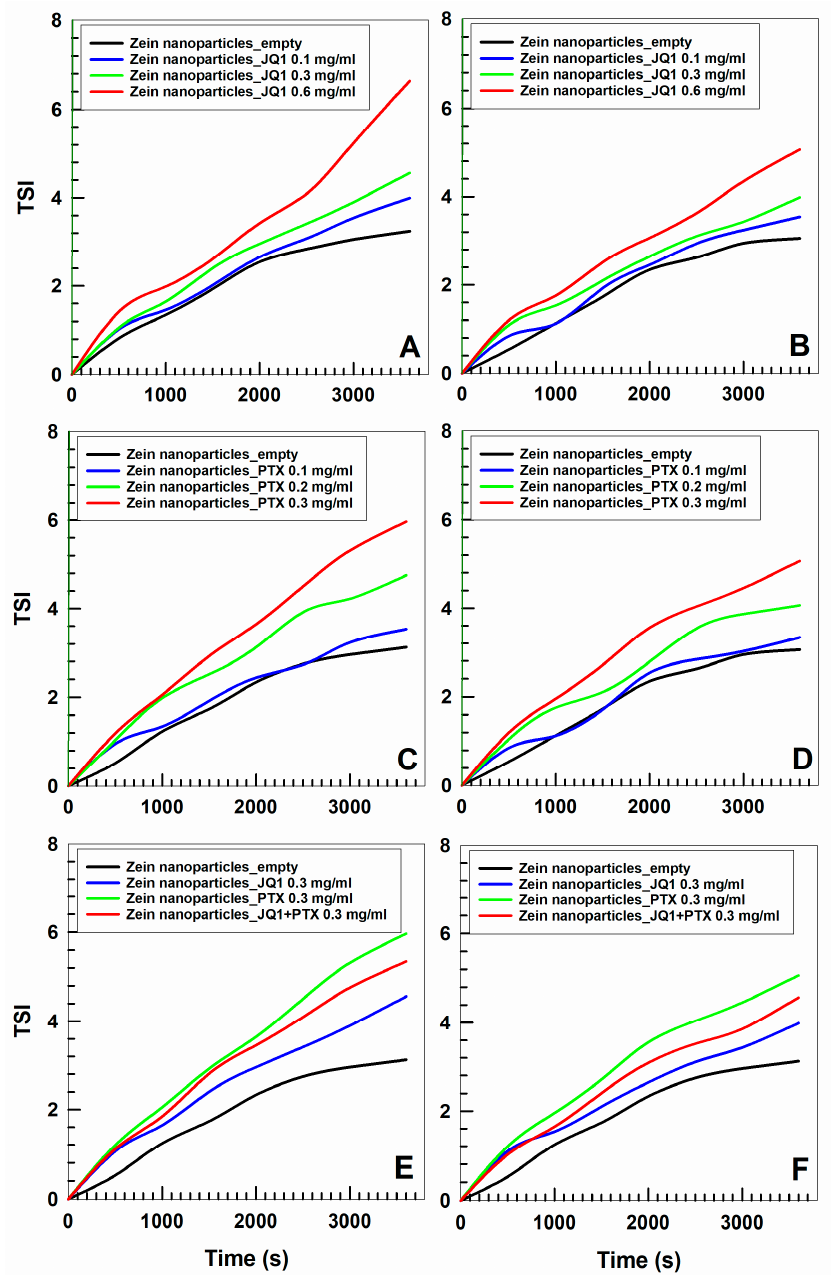
Figure 2. TSI profile of zein nanoparticles prepared with various amounts of JQ1 (0.1, 0.3, 0.6 mg/mL) and PTX (0.1, 0.2, 0.3 mg/mL) as a single agent or as multidrug carrier (0.3 mg/mL of each active compound) as a function of time and temperature (panels ( A , C ) and ( E ): 20 °C; panels ( B , D ) and ( F ): 37 °C).